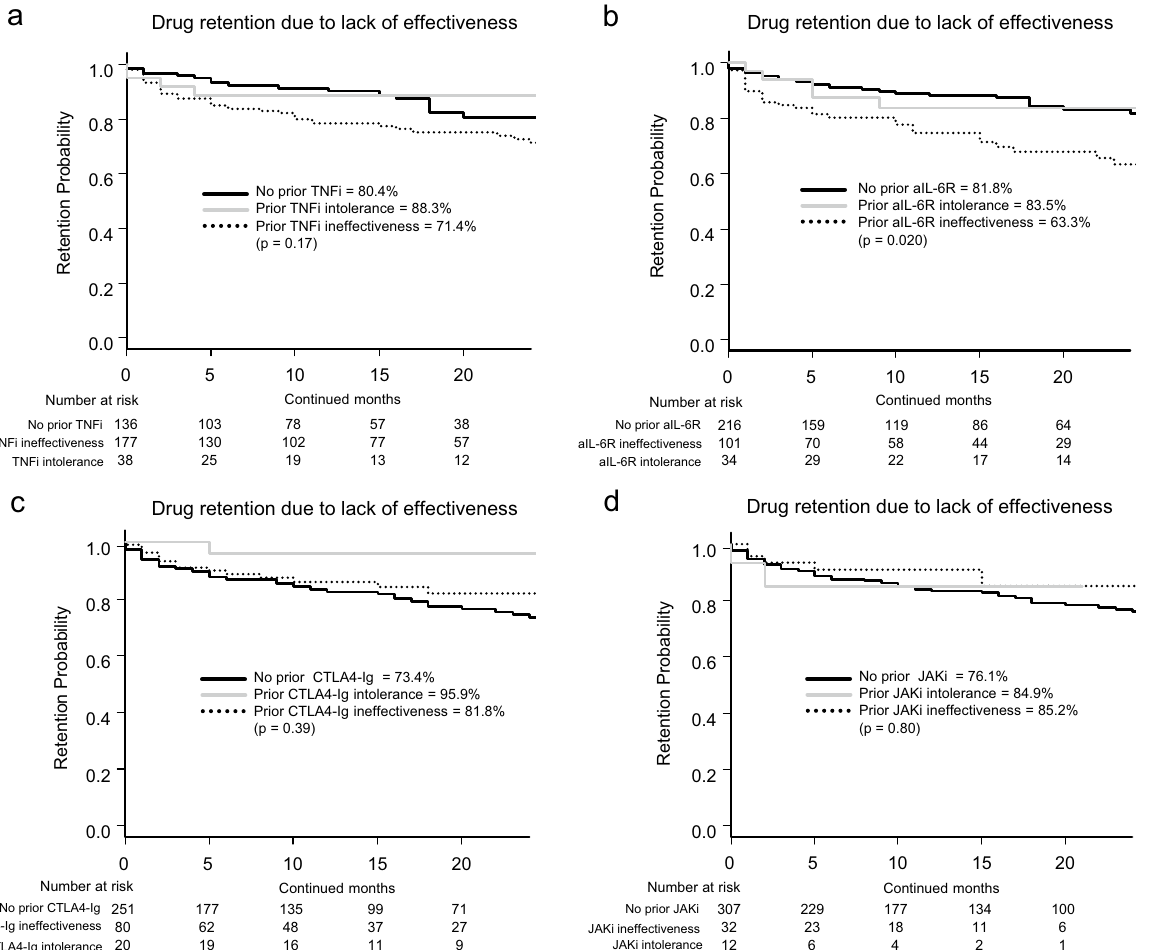
Figure 3. Adjusted drug retention by TNFi, aIL-6R, CTLA4-Ig and JAKi experience. Adjusted drug retention due to lack of effectiveness between ( a ) non-TNFi-experienced, prior TNFi intolerance, and prior TNFi ineffectiveness groups, ( b ) non-aIL-6R-experienced, prior aIL-6R intolerance, and prior aIL-6R ineffectiveness groups, ( c ) non-CTLA4-Ig-experienced, prior CTLA4-Ig intolerance, and prior CTLA4-Ig ineffectiveness groups, ( d ) and non-JAKi-experienced, prior JAKi intolerance, and prior JAKi ineffectiveness groups. TNFi tumour necrosis factor inhibitor, aIL-6R anti-interleukin-6 receptor, CTLA4-Ig cytotoxic T lymphocyte- associated antigen-4-Ig, JAKi Janus kinase